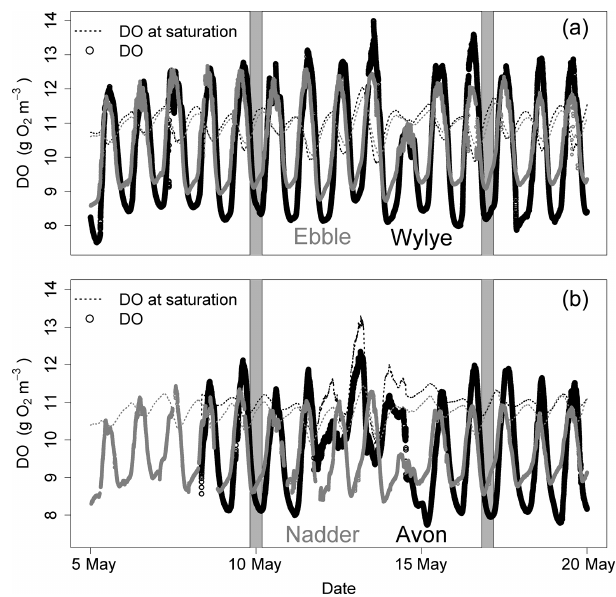
Figure 1. DO time series for 5 to 20 May 2015 for two Chalk streams (a) and two Greensand streams (b) . Solid grey areas are the nights of 9/10 and 16/17 May.